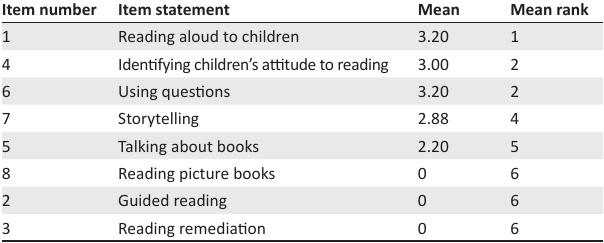
TABLE 4: Mean and mean rank of primary 5 teachers’ frequency of use of reading interest activities. Item number Item statement